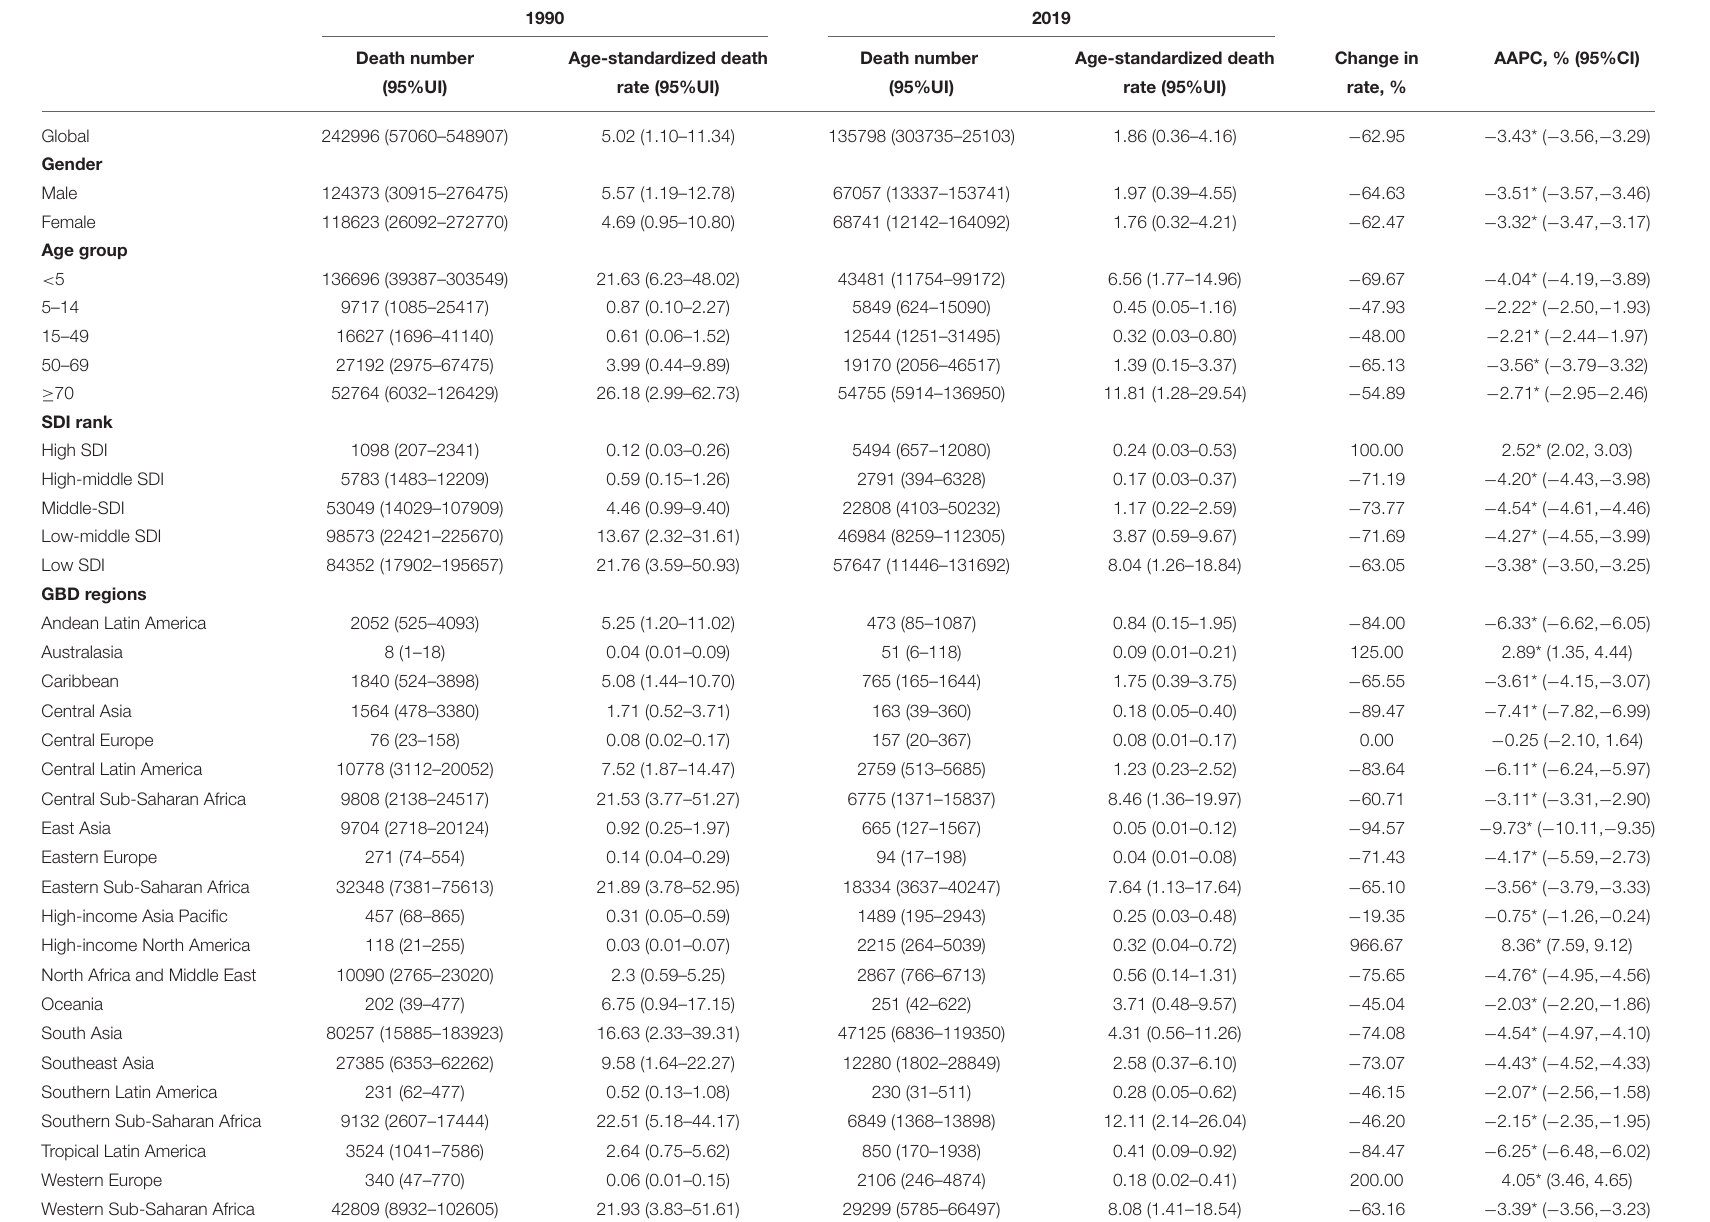
TABLE 1 | The number and age-standardized death rate (ASDR) of norovirus-associated diseases (NADs) in 1990 and 2019 with change rate and average annual percent changes (AAPCs) over the 30